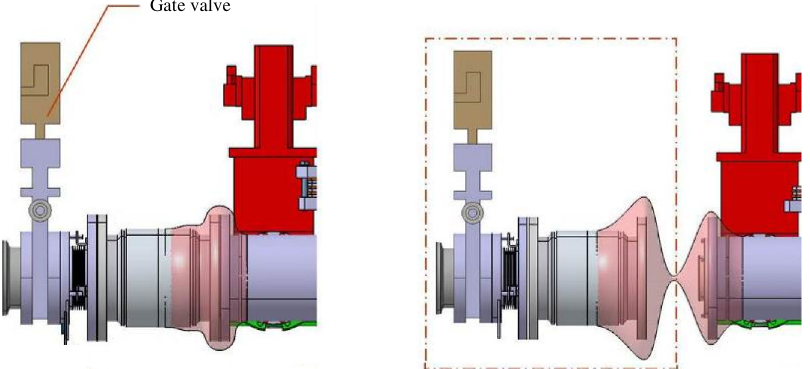
FIG. 14. Technical processes for safety withdraw of elements from the device beam line: setup of the vinyl at the extremity of the insulator (left); separation of volumes by welding the vinyl